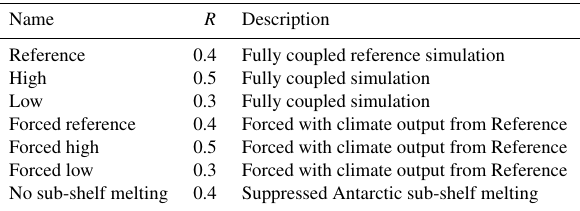
Table 1. Overview of all discussed model experiments. The second column gives the scale factor R for temperature anomalies over the Greenland ice